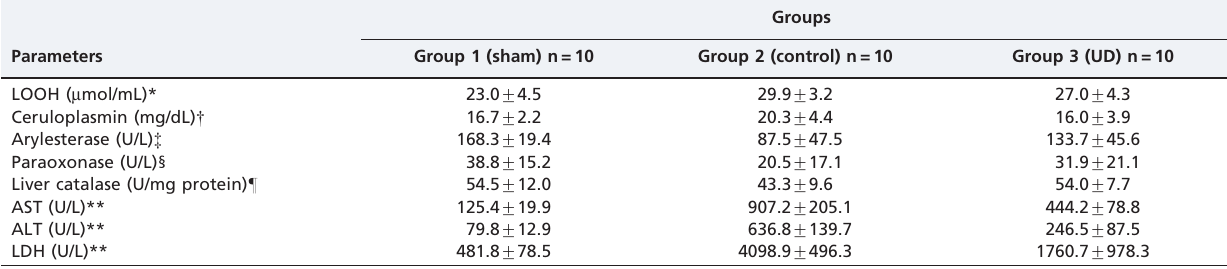
Table 1 - Biochemical markers in groups.